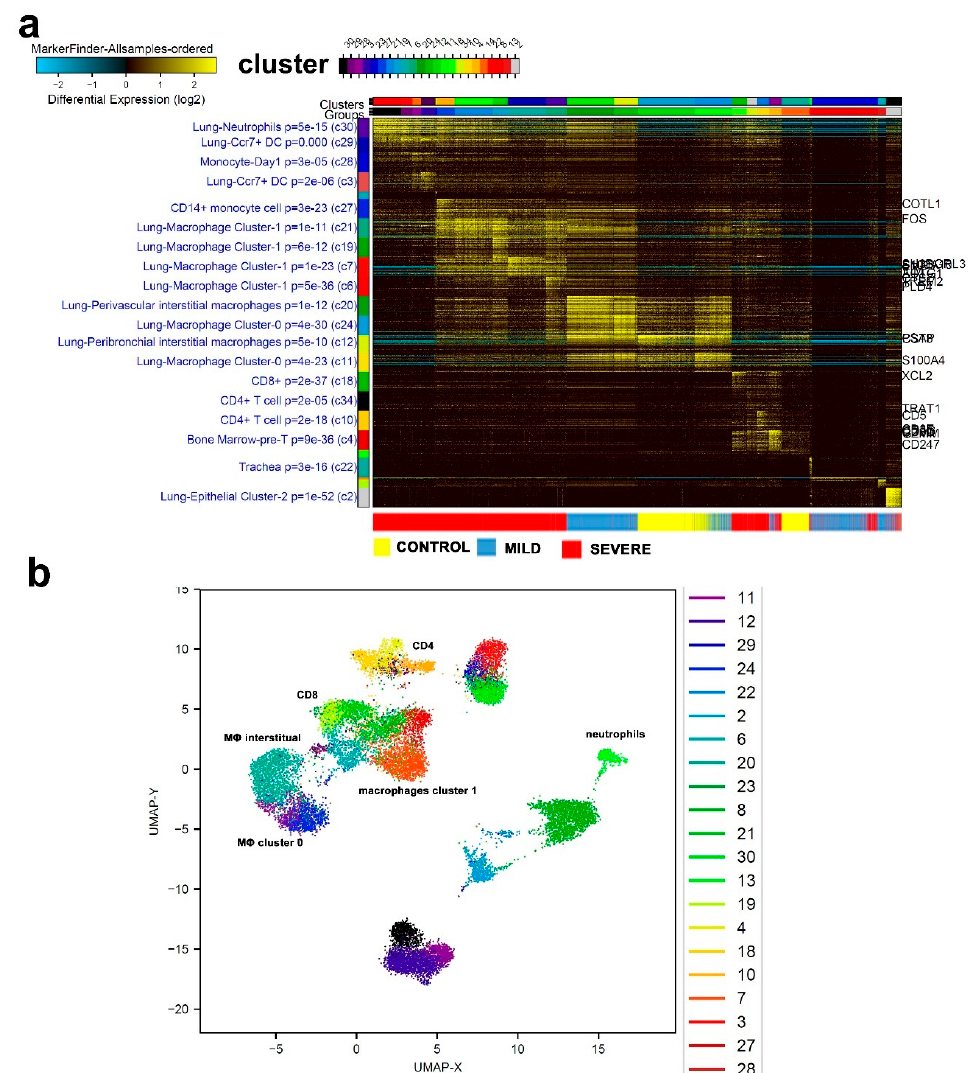
Figure 4. Combined single-cell analysis of BAL from severe- and mild-COVID-19 patients compared to healthy subjects. A total of 16,310 BAL-derived single cells from two healthy subjects, three patients with mild COVID-19, and five patients with severe COVID-19 were subjected to singl- cell analysis. Data are displayed as heat map ( a ) with the enriched cell population indicated on the left. ( b ) UMAP dimensionality reduction visualization of cell clusters corresponding to data presented in panel a with selected enriched cell populations indicated. M Φ :